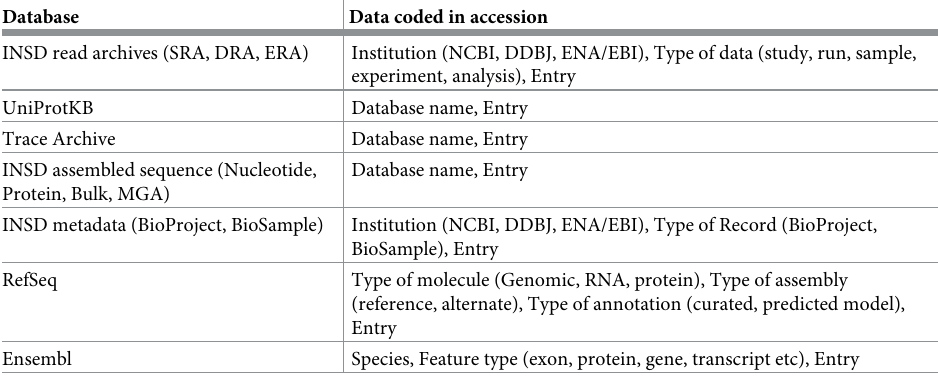
Table 5. Accession identifiers of NCBI, DDBJ, ENA/EBI and UniProt sequence databases defined in the spec/ accessions.yaml TextFormats